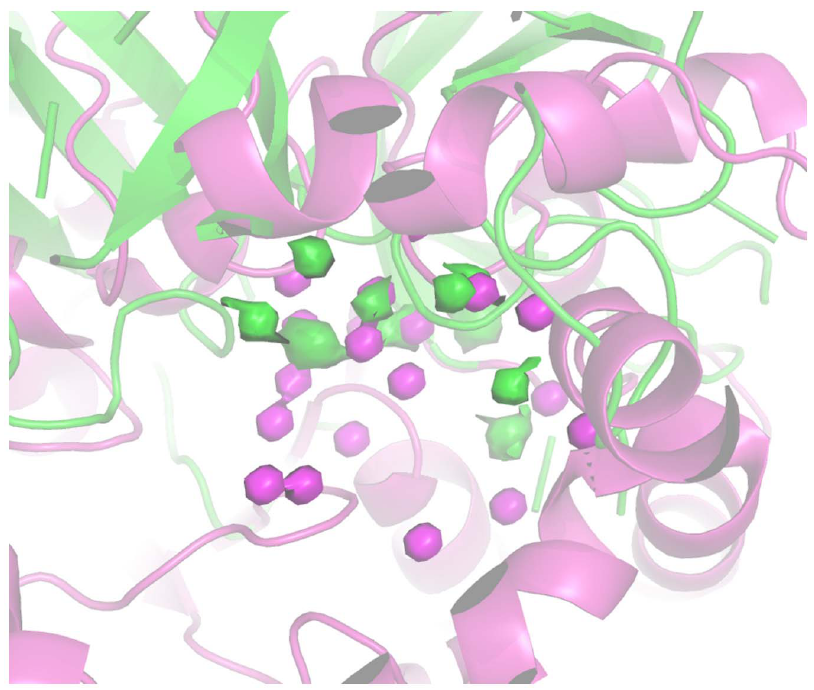
Figure 10. Comparison of 1GVK (protease) and 2W22 (lipase) active site H-bond acceptor pseudo-MIFs. 1GVK and 2W22 are represented as green and magenta cartoon respectively. 1GVK pseudo-MIFs are represented as green surfaces. 2W22 pseudo-MIFs are represented as magenta surfaces.